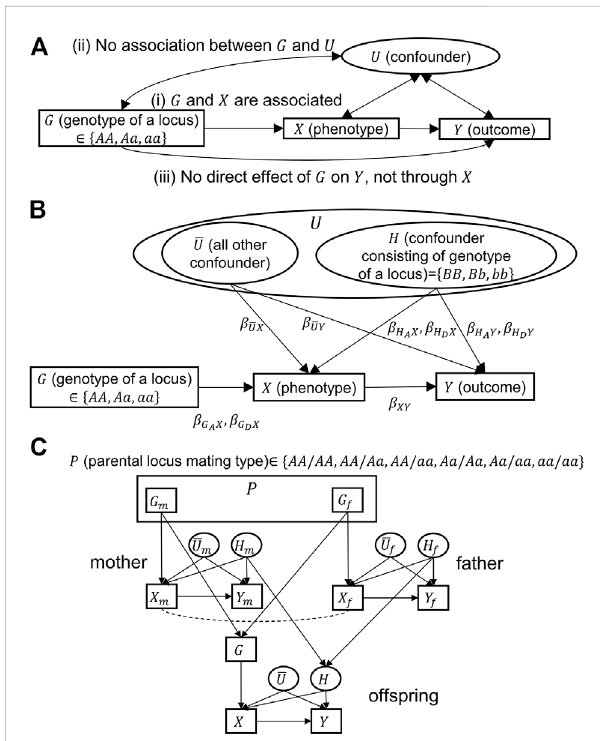
FIGURE 1 Causal models for Mendelian randomization. Directional and bidirectional arrows correspond to causal and associational relationships, respectively. β s are regression coef fi cients. Variables in rectanglesandovalscorrespondtomeasurableorunmeasurable variables, respectively. (A) Generalized model for Mendelian randomization (MR) with three assumptions. (B) Explicit causal model separating confounding variables, U , into the variable consisting of unlinked heritable variants in the nuclear genome, H , and all other confounding variables, (cid:2) U . (C) Explicit causal model for the father – mother – offspring trio. The parental mating type, P , is the combination of parental genotypes ( G m and G f ), which takes one of the six possible values. The dotted line connecting X m and X f implies assortative mating of these